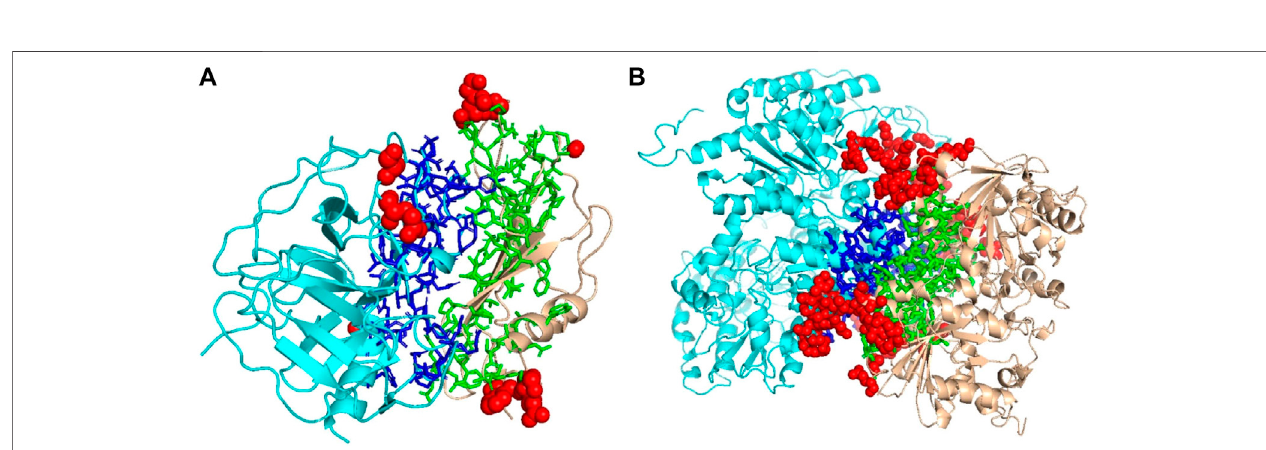
FIGURE 6 | Examples of decoys with an acceptable quality but not selected within the top 10 by DOVE. Two subunits docked are shown in cyan and light brown, and the interface regions of the two subunits are presented in the stick representation and in blue and green, respectively. To highlight the missed atoms from the input cube of DOVE, they are shown in red spheres. (A) A medium-quality decoy for 1bui. iRMSD: 2.54 Å, lRMSD: 2.93 Å, fnat: 0.551. (B) A medium-quality decoy for 1g20. iRMSD: 2.14 Å, lRMSD: 3.86 Å, fnat: